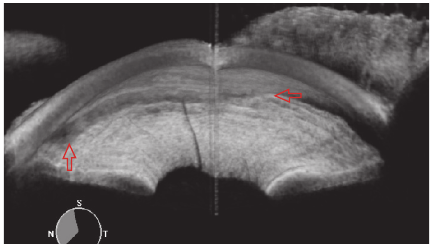
Figure 2: A nasal quadrant screenshot of the video gonioscopy of the post-Trabectome patient which gives information about the trabecular cleft of the angle morphology in high resolution circumferentially in 360 degrees. Red arrows show the Trabectome surgical site.